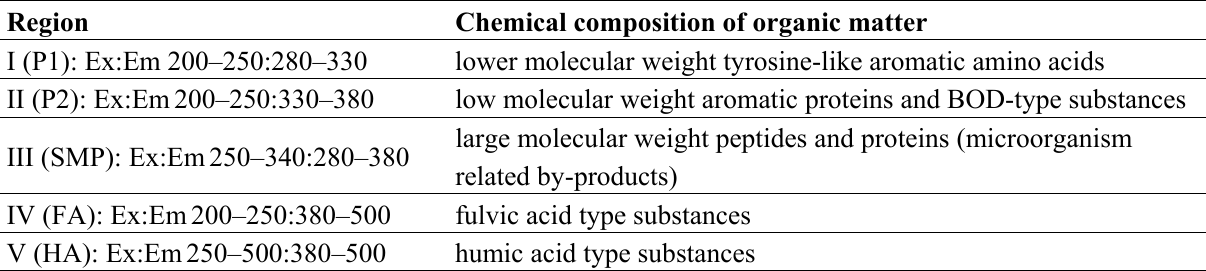
Table 1. Five major regions in excitation emission matrix (EEM) spectra according to Chen et al. (2003) [23]. SMP, soluble microbial by-product; FA, fulvic acid; HA, humic acid.